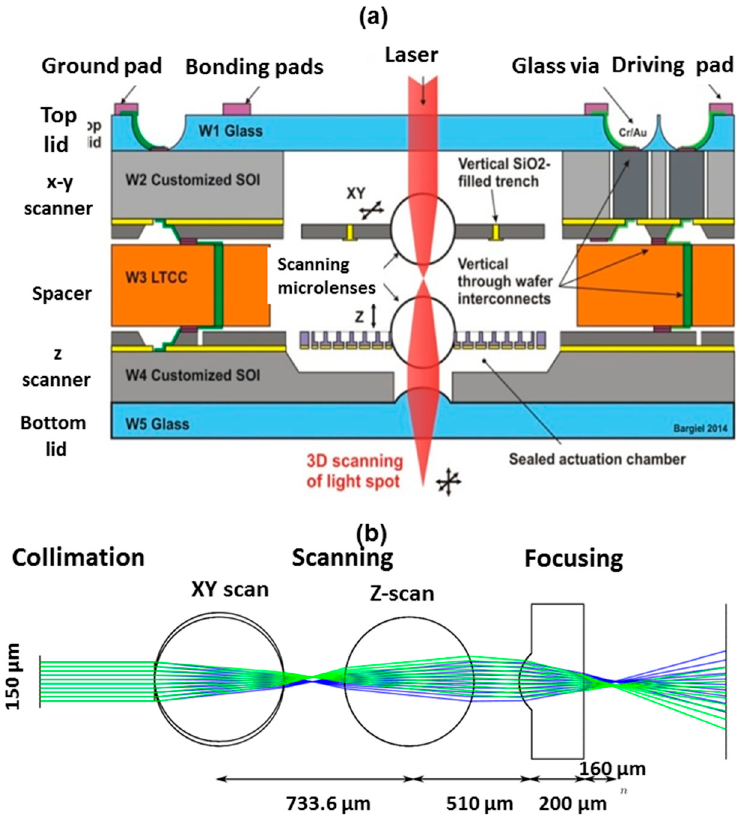
Figure 2. 3D microoptical scanner: ( a ) cross-sectional view of microscanner; and ( b ) optical design of the microscanner based on three blocks: collimation block, scanning block with afocal doublet, and focusing block.